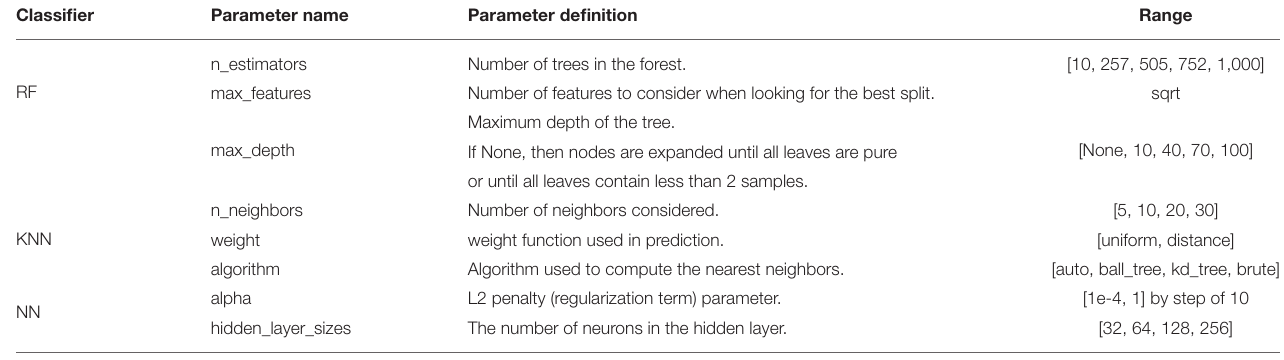
TABLE 4 | Hyperparameters values tested during the grid search procedure, with chosen ranges and step values for each parameter. Classifier